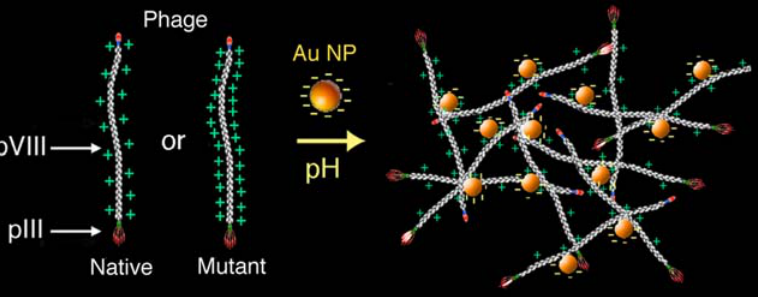
Figure 1. Scheme of Au-phage hydrogel assembly with native and mutant phage. The pVIII and pIII arrows point to the major (white region) and minor phage (red region) capsids, respectively (not drawn to scale).